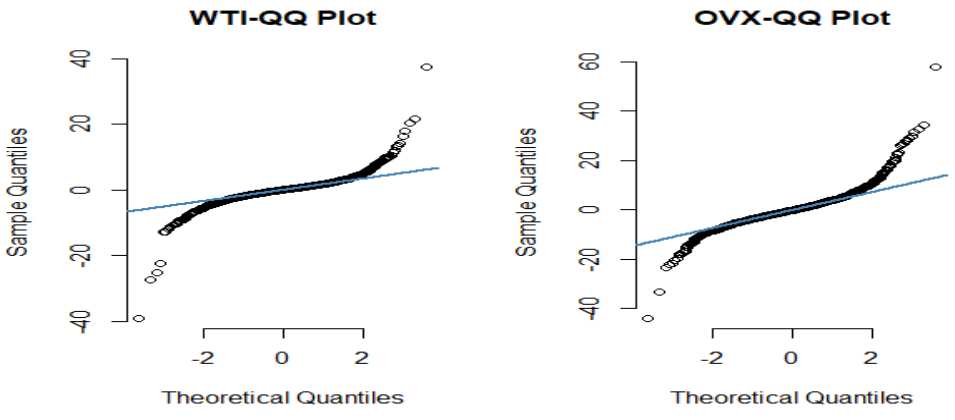
Figure 2. Q-Q plots of the series. Figure 2 . Q-Q plots of the series. Table 2. Results of Brock–Dechert–Scheinkma (BDS) statistics from VAR residuals.